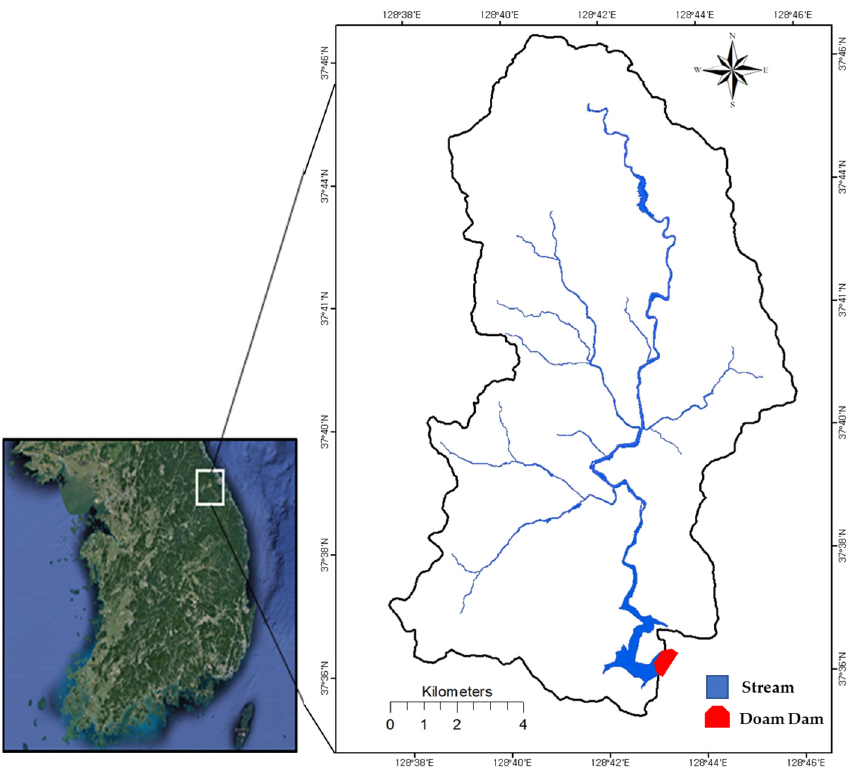
Figure 3. The Doam Basin in Korea